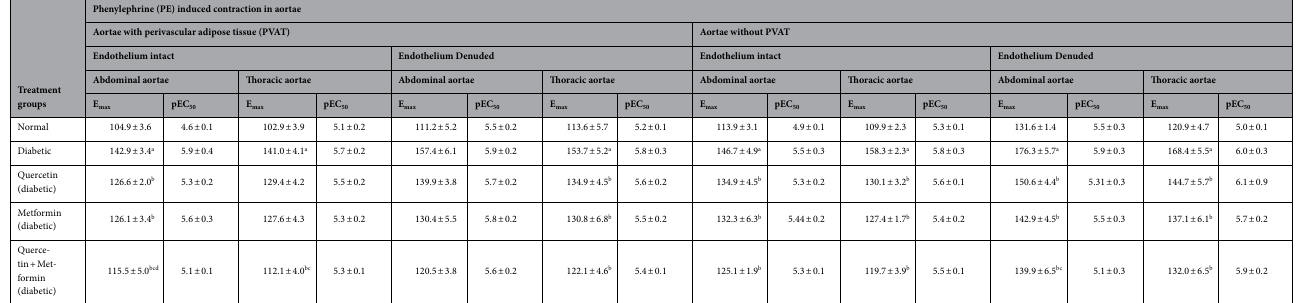
compared to the control. Only mild infiltration of inflammatory cells and eosinophilic deposits were observed in this group (Fig. 6). Abdominal and thoracic aortae. The rats in the control group showed a typical blood vessel architecture. STZ treatment caused focal fat depositions in tunica intima and mild tunica media enlargement. The diabetic rats